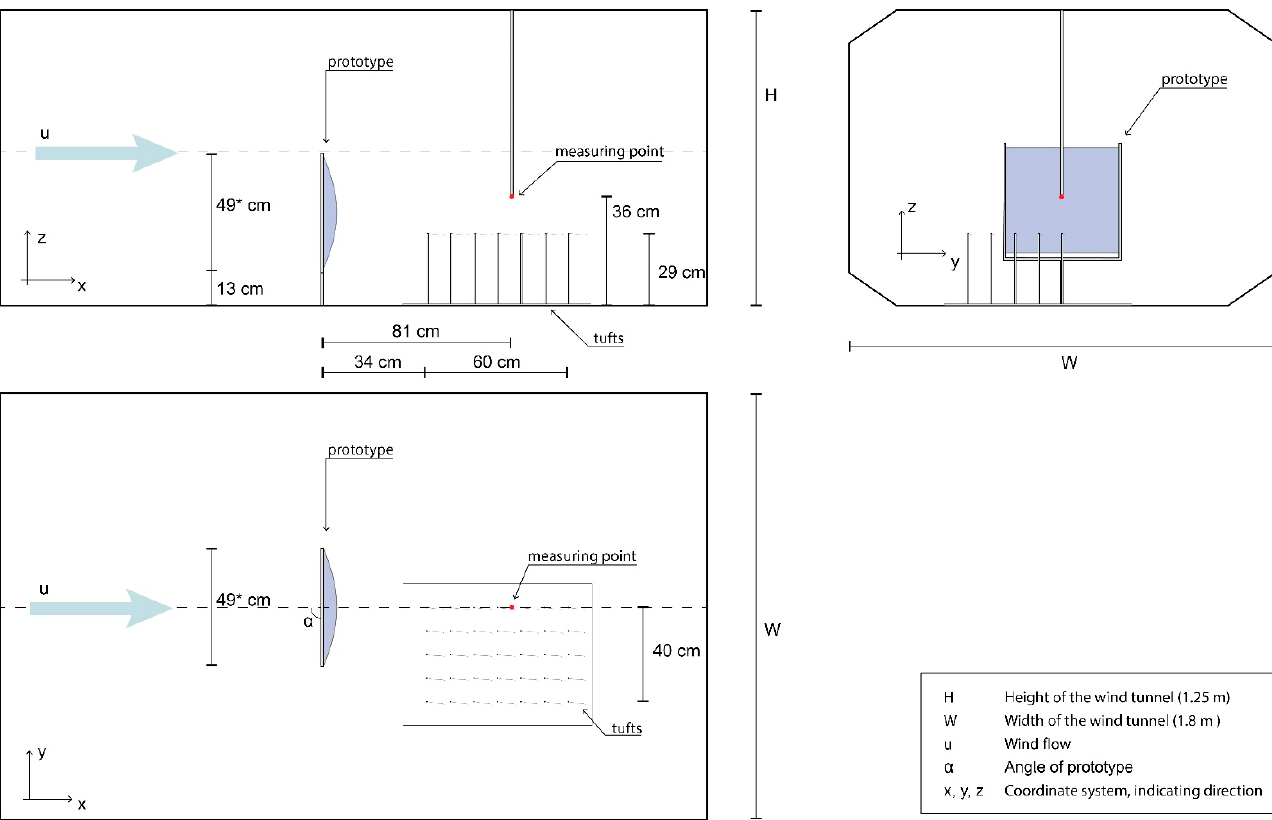
Figure 8. The wind tunnel setup for the experiments. Top left, side elevation view; top right, front elevation view; and bottom left, top plan view. Compare with photo in Figure 9. * width of steel frame, center to center of the steel